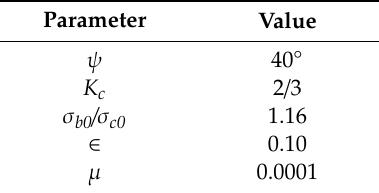
Table 3. Concrete damaged plasticity (CDP) model input parameters.